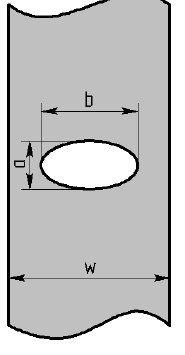
Fig. 7. Defect – vertical